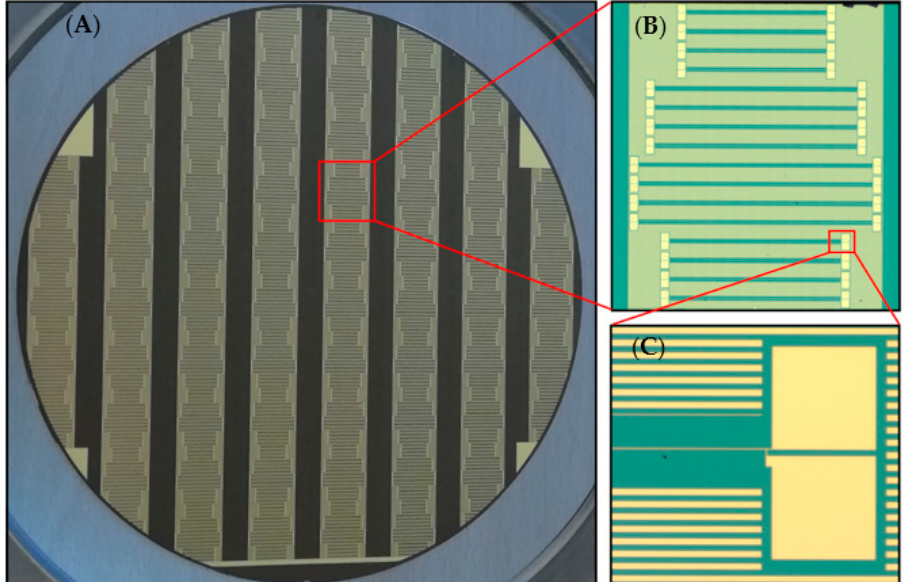
Figure 5. ( A ) Optical image of a complete wafer with repeating 3 ω structures. ( B ) Optical microscope image of a full set of 16 heaters with different lengths and widths (zoomed into ( A )). ( C ) Microscopic image of the contact pads on each side (zoomed into ( B )).